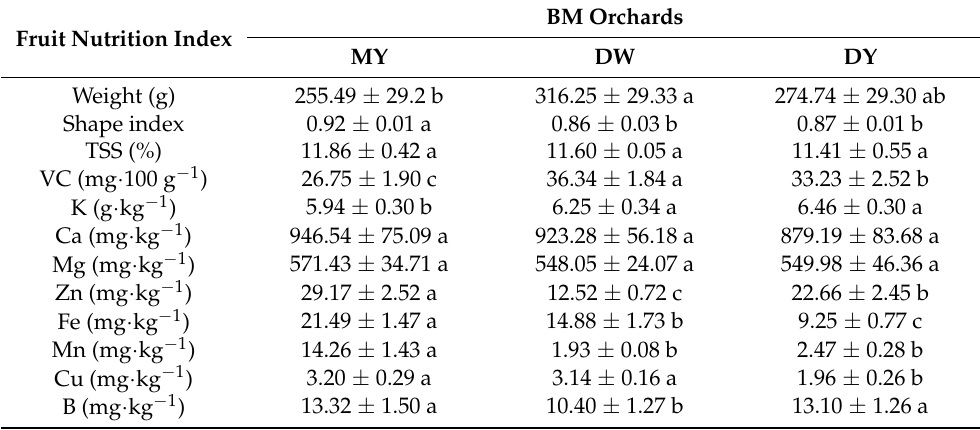
Table 3. Fruit quality and mineral nutrient concentration of the citrus hybrid cv. Beni-Madonna, the significant difference of different citrus orchards at p < 0.05 was indicated by small letters. Fruit Nutrition